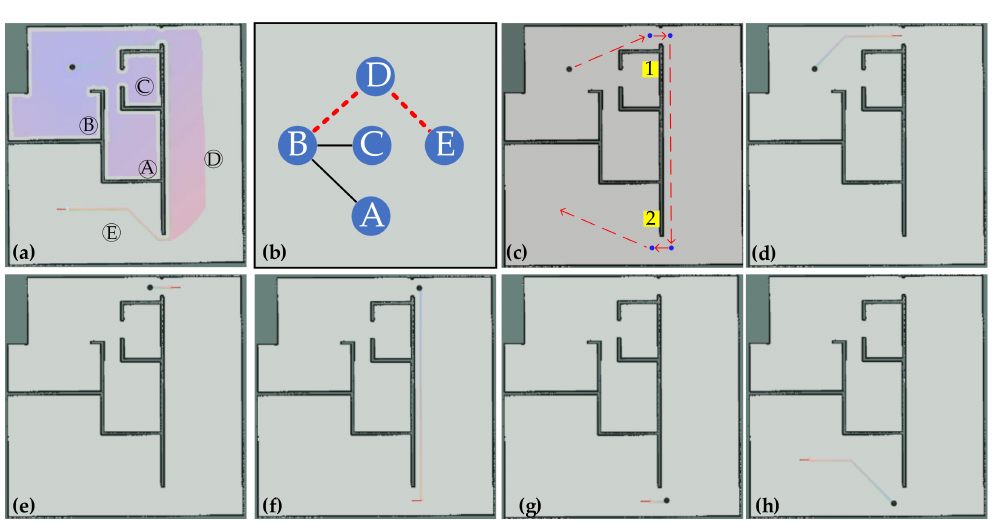
Figure 6. The comparison of A* algorithm and segmented global path planning. ( a ) A* algorithm. ( b ) Topological map: the red dotted line is the topological path. ( c ) auxiliary navigation points (ANPs) sequence ( d – h ) segmented global path planning. The colorful cell means the cells traversed.